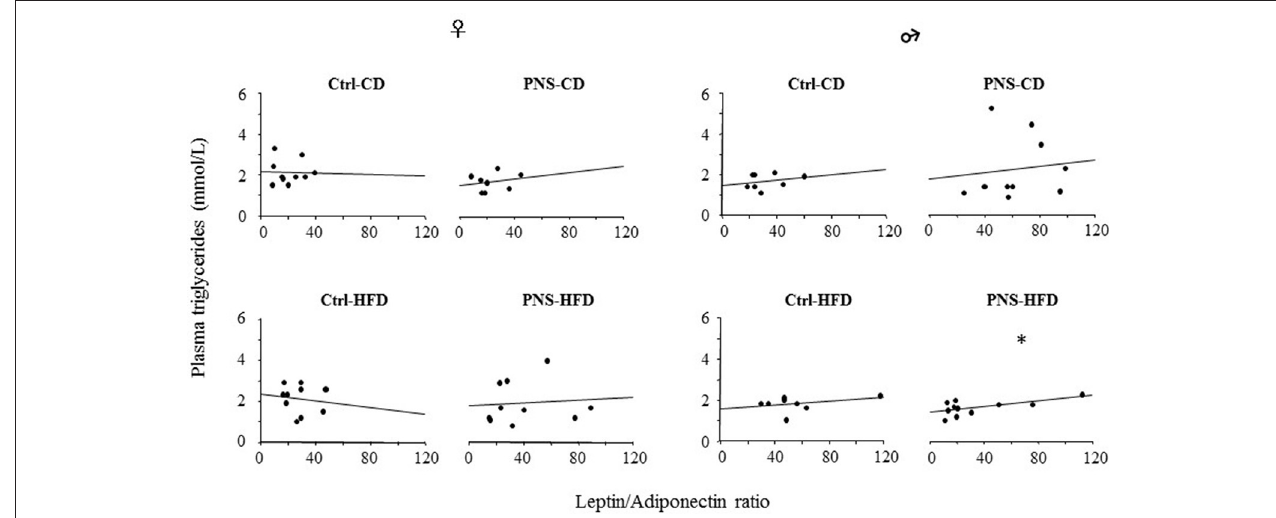
FIGURE 4 | The L/A ratio, a marker of metabolic risk, correlates positively with circulating triglyceride levels only in PNS-HFD males suggesting that a double insult might predispose to a condition of metabolic vulnerability in this sex. The graph represents a linear regression plot. * p < 0.05; R 2 = 0.384.